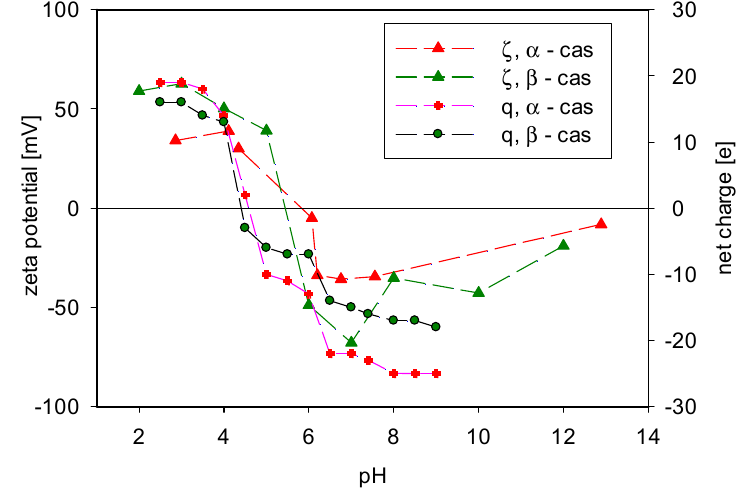
Figure 3. The dependence of zeta potential of α -casein and β -casein on pH value shown together with the calculated net charge of casein molecules obtained with the AutoSMILES procedure [55].